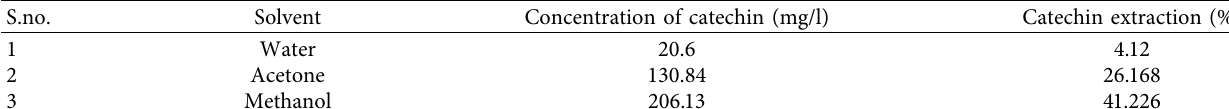
Table 2: Effect of different solvents on catechin extraction %.